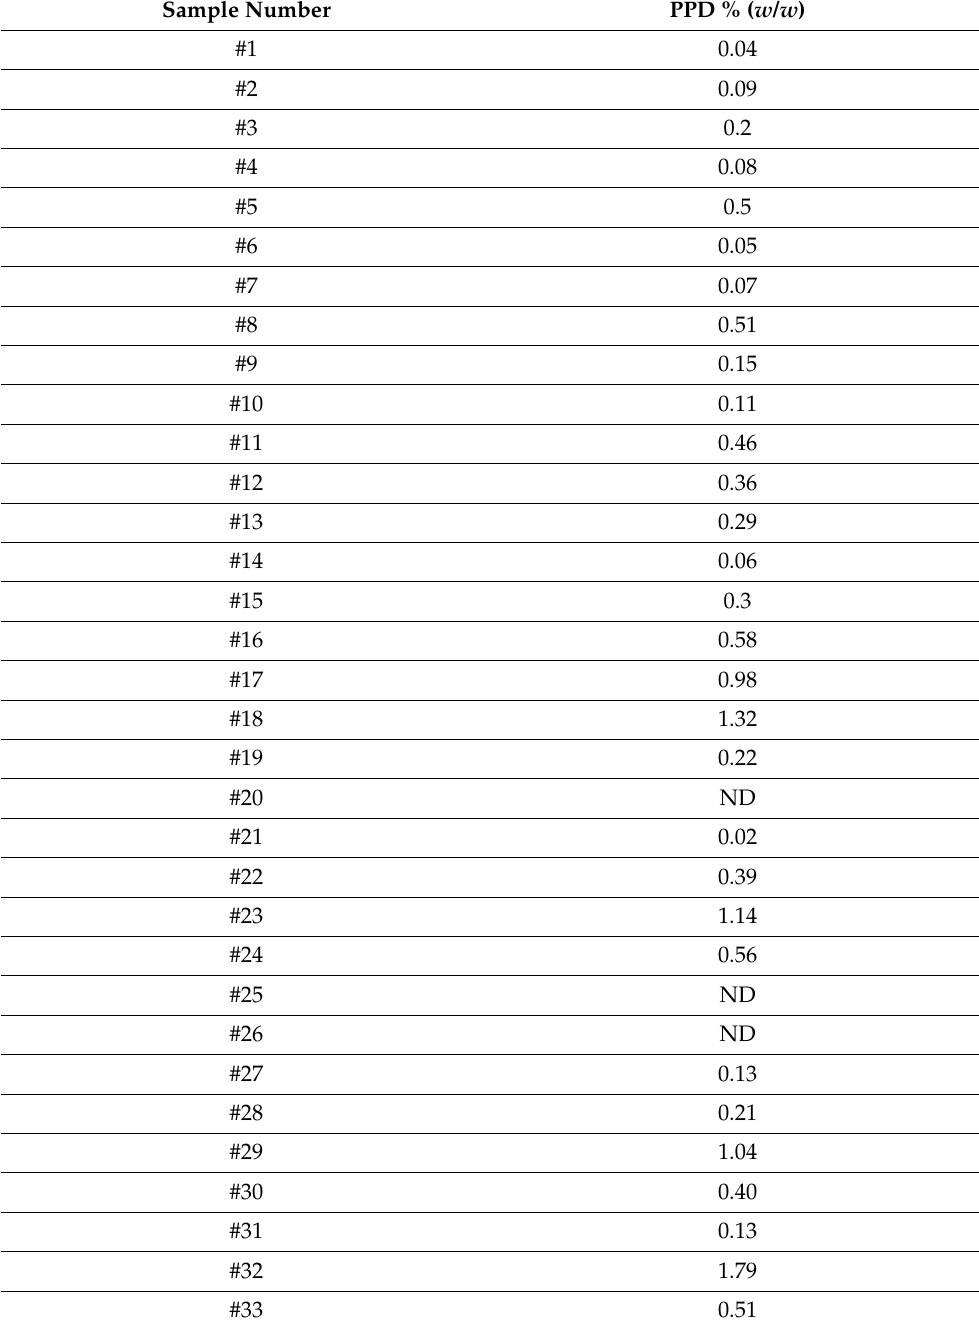
Table 6. Contents (% w / w ) of PPD identified in the investigated hair dye products. ND: not